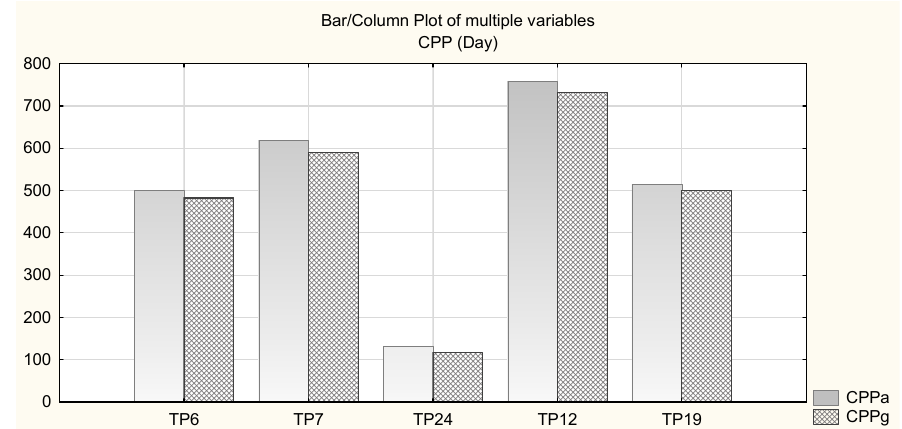
Fig. 3. Comparison of the actual and goal values of the CPP indicator One of the significant output performance indicators is ROS indicator. The goal values of this indicator are to be found in Fig. 4.